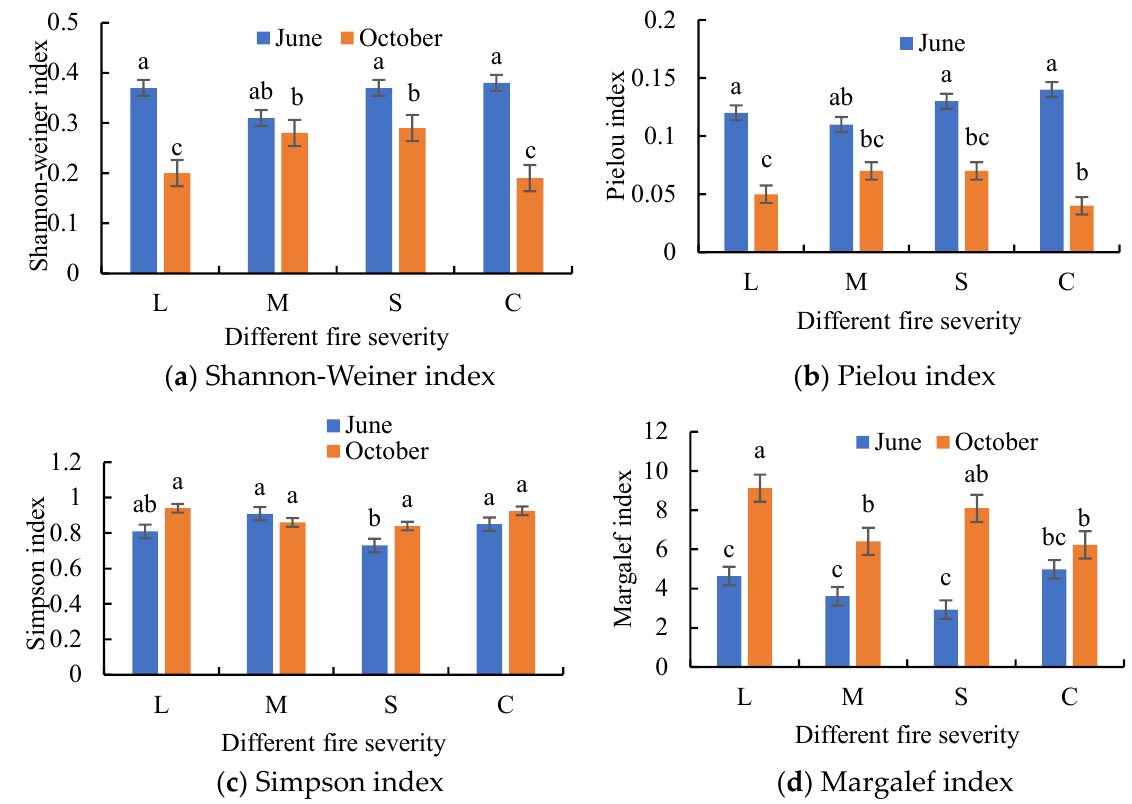
Figure 3. The species diversity indices among different fire severity. L: lightly burned area, M: mod- erately burned area, S: severely burned area, C: control group. The error bar is the standard deviation. a, b, and c are different and significantly different from each other, but for ab and a or ab and b, there are repeated letters, so there is no significant difference between the two pairs, and there is a significant difference between ab and c.